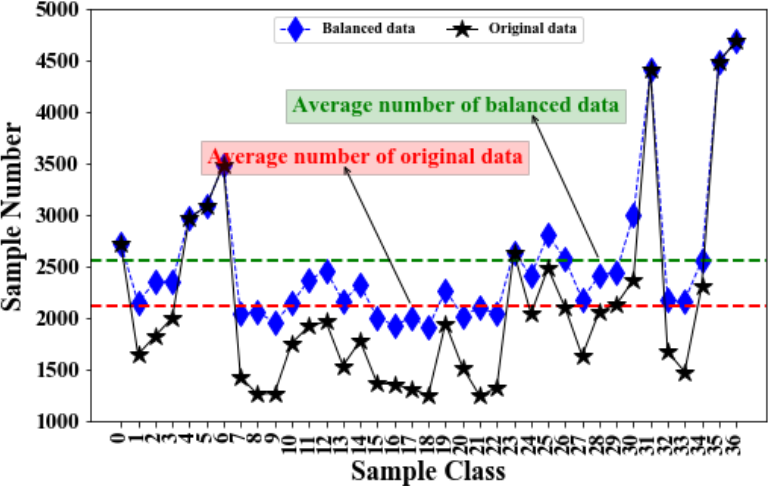
Figure 8. Sample statistics before and after sampling.